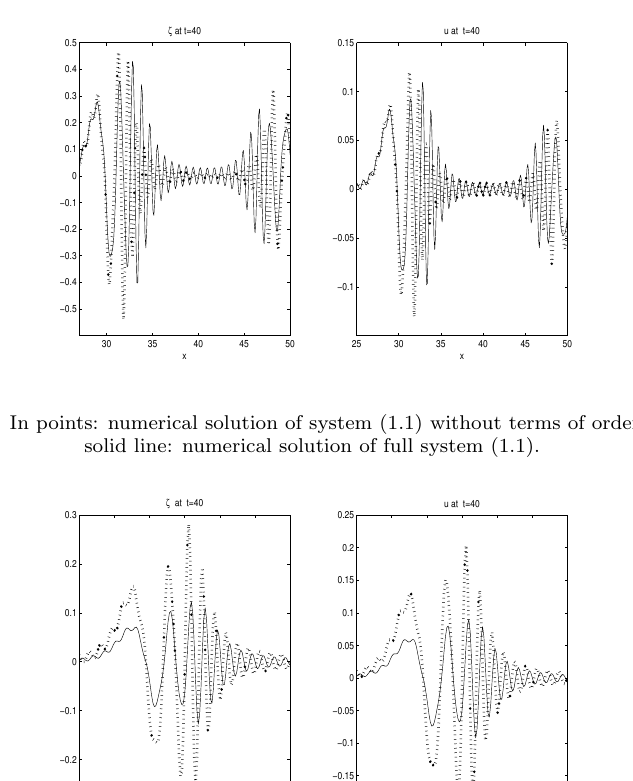
predicting the propagation of internal water waves in the physical regime ana- lyzed by the present